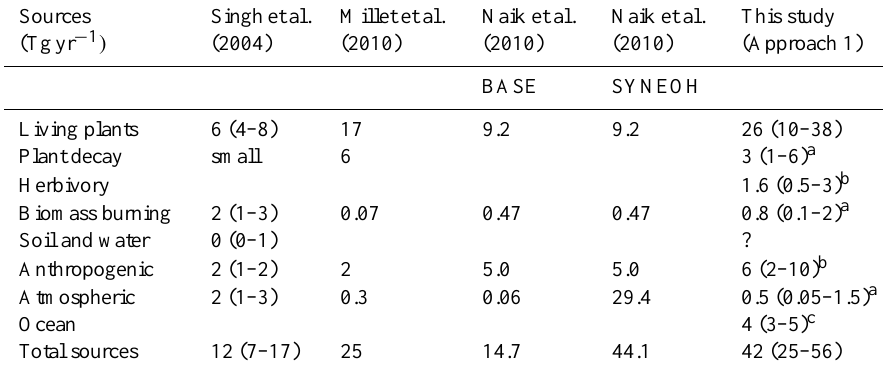
Table 1. Global atmospheric sources of ethanol in Tg (ethanol)yr − 1 . Numbers in parentheses are estimated ranges of the sources and sinks.